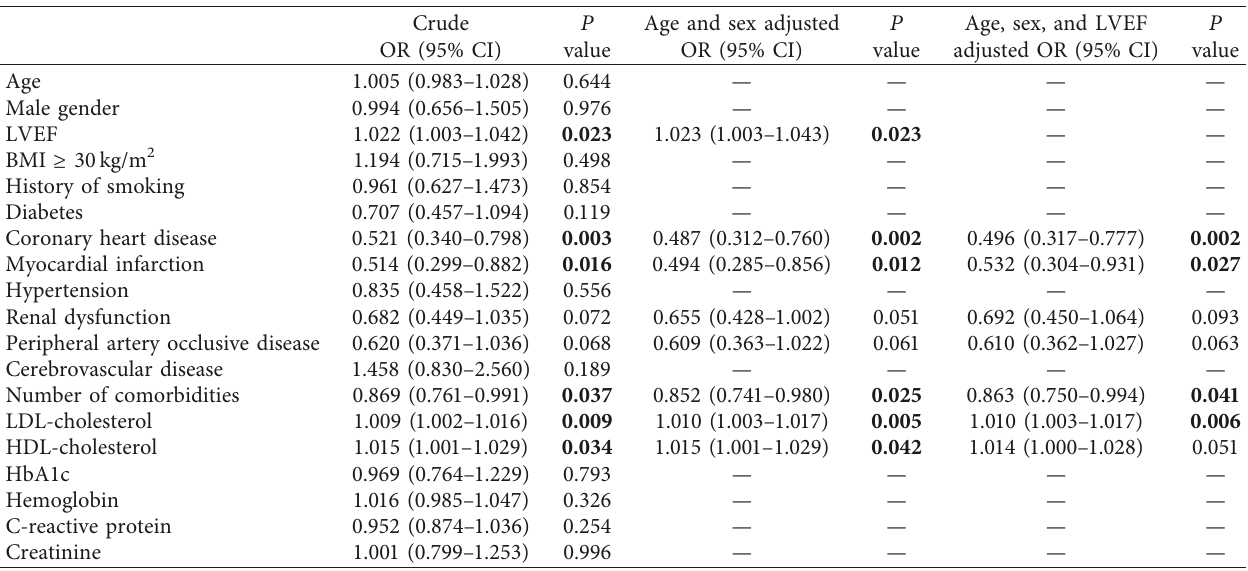
Table 5: Odds ratio of cardiac comorbidities and risk factors and laboratory parameters at baseline associated with fast P